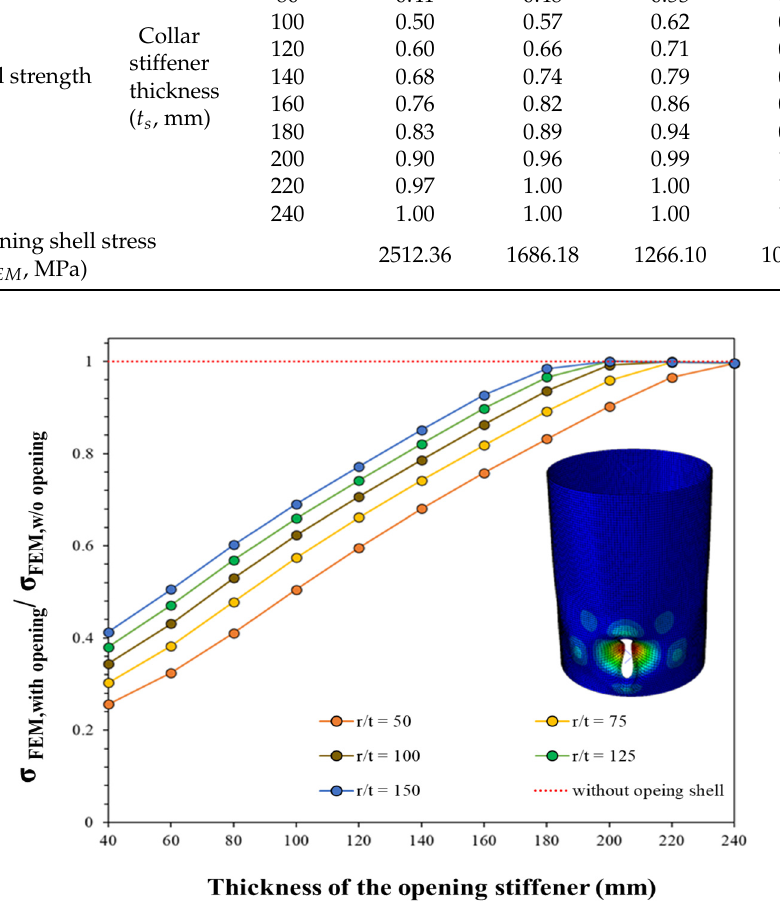
Figure 9. Comparison of linear buckling analysis results based on collar stiffener thickness.